Question: Which kind of chart has been used to present this data?
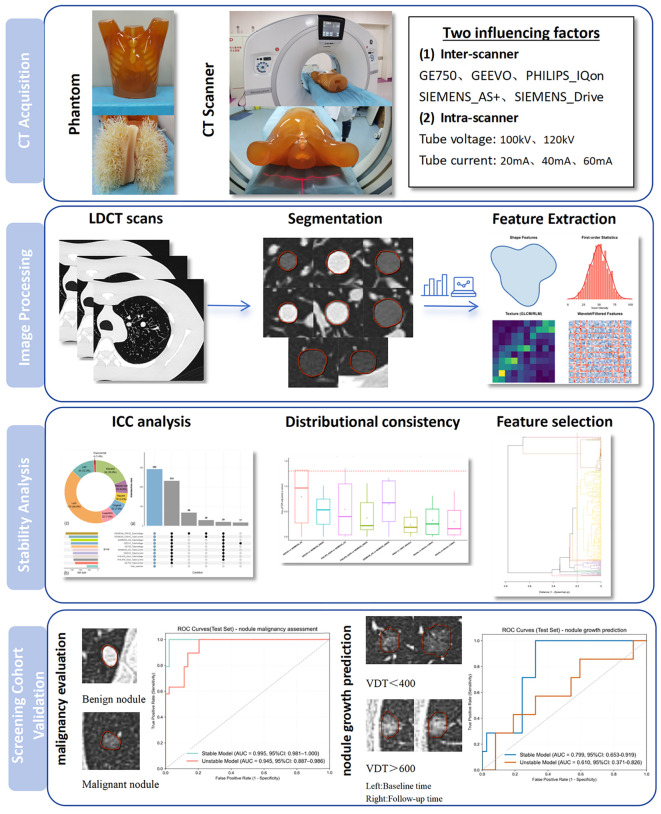
Answer: line